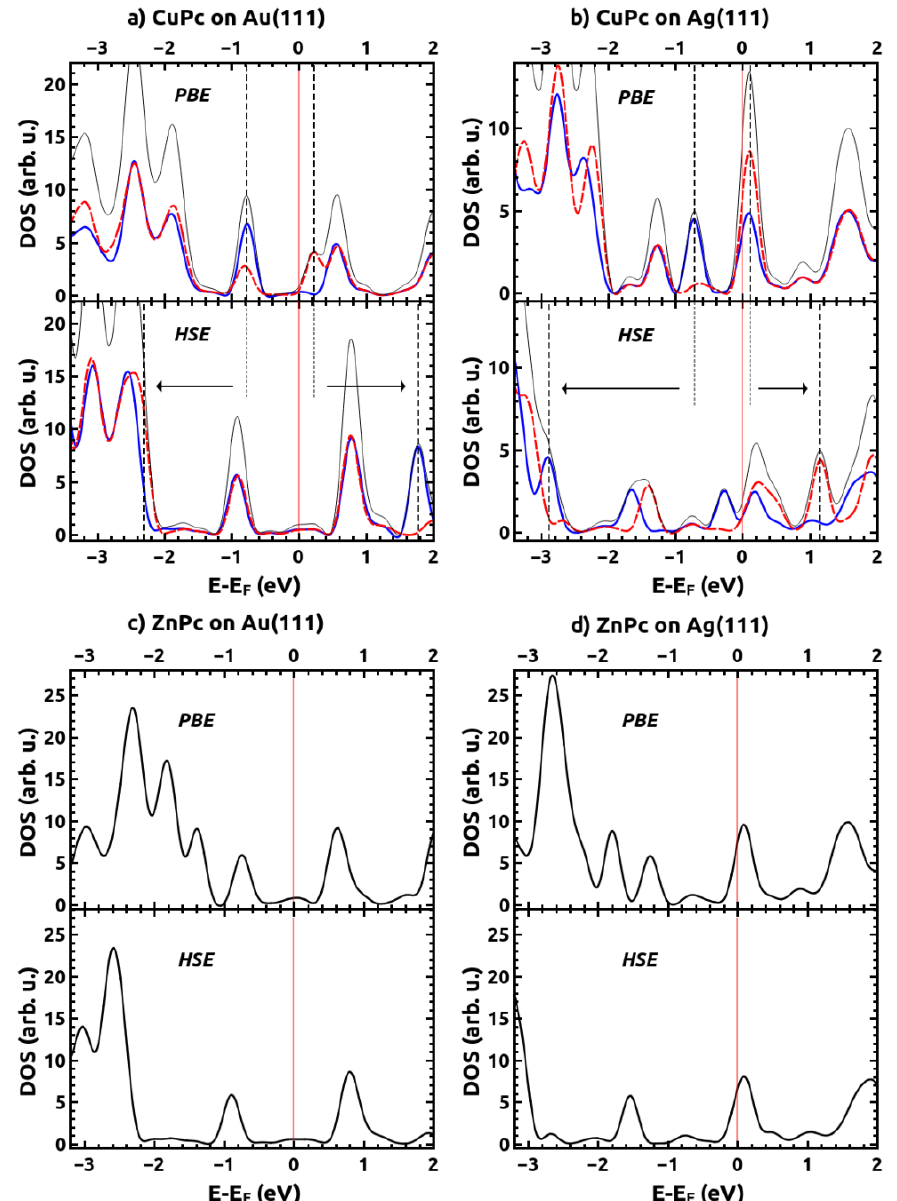
Figure 6. Computed density of state (DOS) for MePc/metal interfaces projected onto the adsorbate layer for ( a ) CuPc on Au(111), ( b ) CuPc on Ag(111), ( c ) ZnPc on Au(111), and ( d ) ZnPc on Ag(111) all calculated using the PBE and HSE06 functionals. For the CuPc/metal interfaces, spin-up (solid blue) and spin-down (dashed-red) spin densities are shown separately and the thin black lines correspond to the total density of states. As ZnPc has an even number of electrons, such a distinction is not necessary in ( c ) and ( d ). The vertical solid red lines indicate the position of the Fermi energy. The dashed lines denote the positions of the singly occupied orbitals in the PBE and HSE06 calculations with the arrows indicating the shift of these orbitals arising from the admixture of exact exchange. For CuPc on Au(111) the position of the occupied spin-alpha orbital around − 2.3 eV is not clearly visible in the DOS plot; it can, however, be unambiguously determined from the difference of the spin-up and spin-down densities shown in the